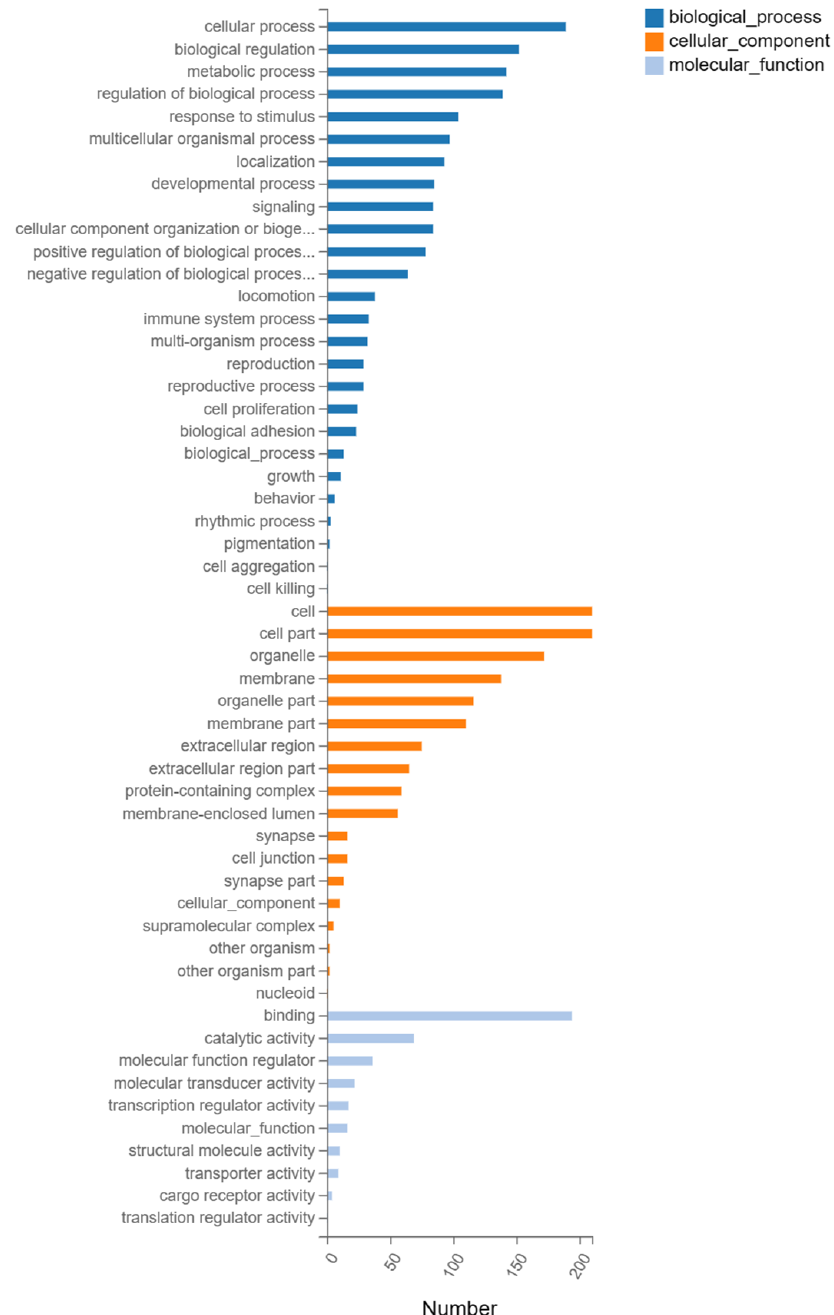
Figure 4. The GO classification of the total genes in HacaT cell after tritium toxicity. GJL vs. DZ of HacaT cells. Table 2. Ten of the most highly enriched signaling pathways by GO enrichment analysis.